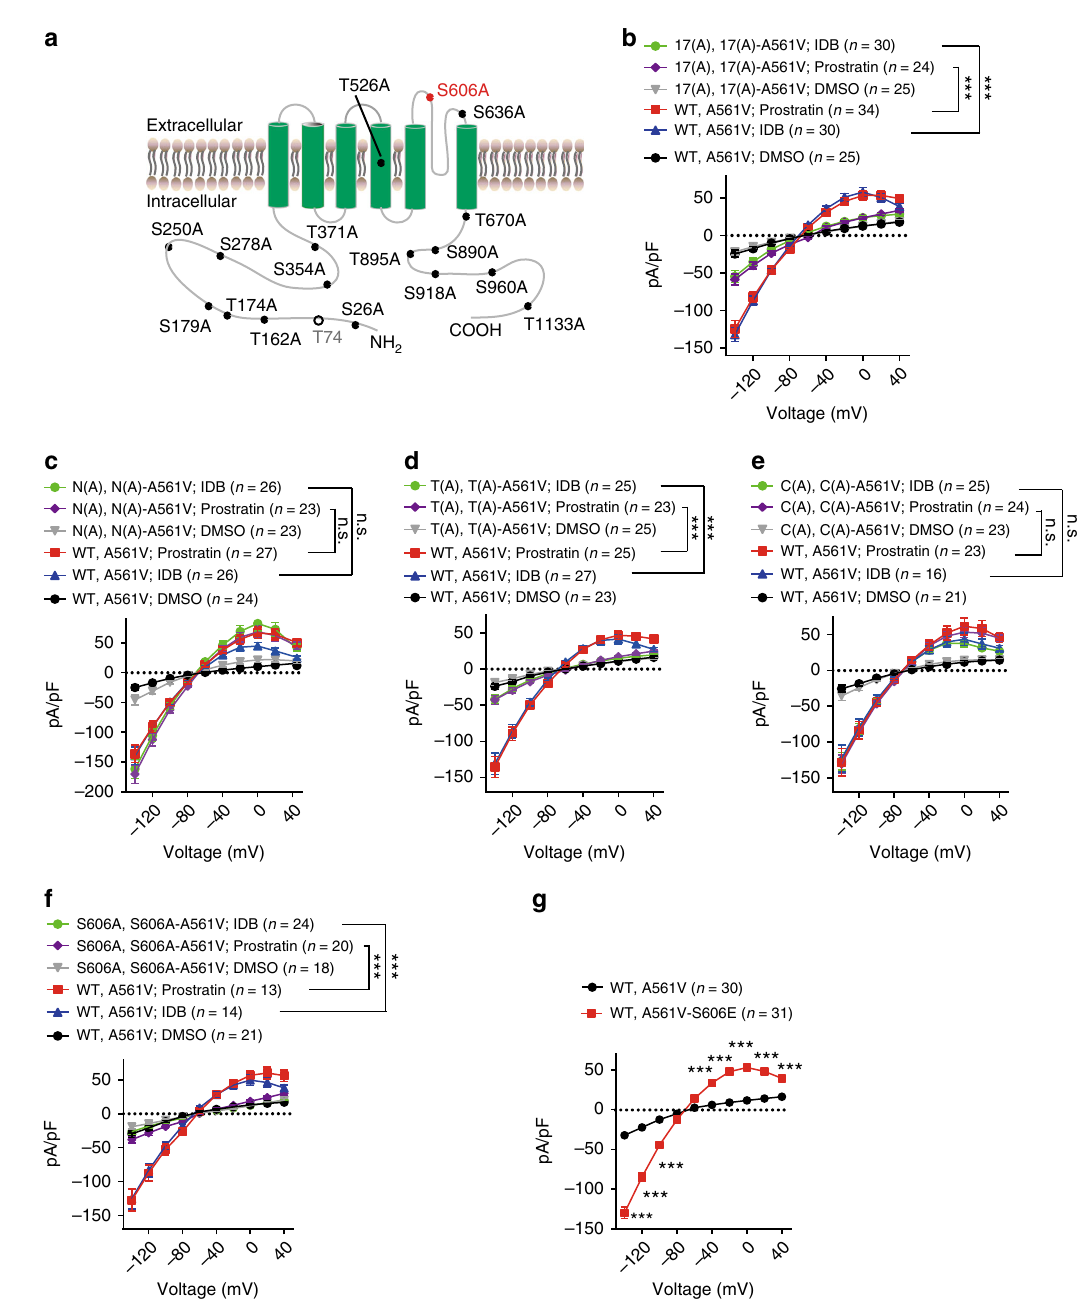
Fig. 5 The action of Prostratin and IDB depends on the phosphorylation of the S606 at the pore region of the hERG channel. a Schematic illumination of putative PKC phosphorylation sites and point mutations in hERG proteins. b Effects of Prostrain and IDB on the current densities of hERG WT -hERG A561V channels with a lack of 17 PKC phosphorylation sites (indicated as 17(A)). c – e Effects of Prostrain and IDB on the current densities of hERG WT -hERG A561V channels with a lack of PKC phosphorylation sites (S26A, T162A, T174A, S179A, S250A, S278A, S354A, and T371A) in the N-terminus (indicated as N (A)), PKC phosphorylation sites (T526A, S606A, S636A, and T670A) in the transmembrane domain (indicated as T(A)), or PKC phosphorylation sites (S890A, T895A, S918A, S960A, and T1133A) in the C-terminus (indicated as C(A)). f Effects of Prostrain and IDB on the current densities of hERG WT - hERG A561V channels with a lack of the S606 PKC phosphorylation site. g Effects of the mutation S606E on the current densities of hERG WT -hERG A561V channels. The ratio of hERG WT /hERG A561V was 2:1. All experiments were performed at least three times. Data shown are mean ± s.e.m. *** P < 0.001, n.s., not signi fi cant (one-way ANOVA Dunnett ’ s test for b , c , d , e , and f ; Student ’ s t tests for g